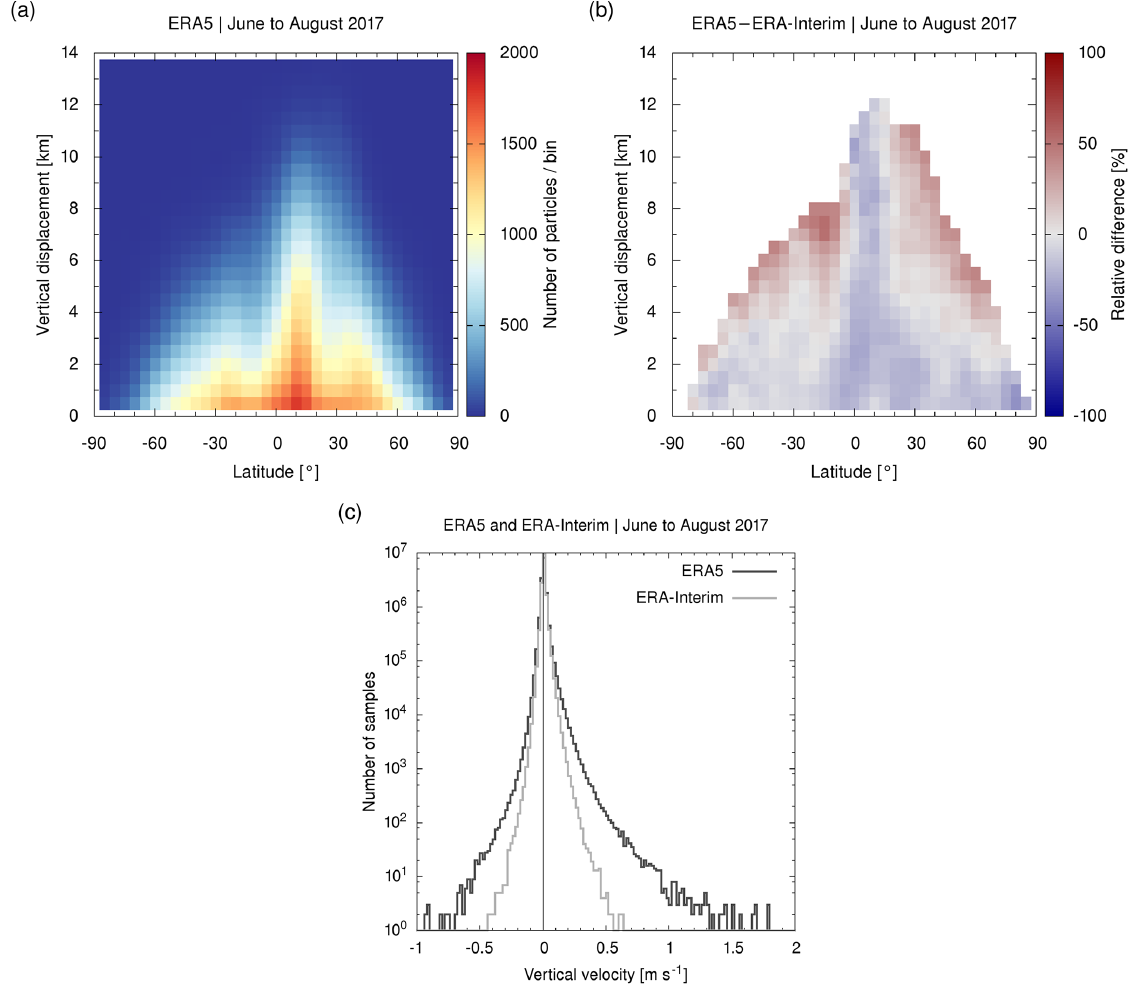
Figure 9. Comparison of total vertical displacements (a, b) and vertical velocities (c) of particles launched at an altitude of 2–8km for six sets of ERA5 and ERA-Interim 10-day forward trajectories from June to August 2017. Only trajectories with net updraft (positive vertical displacement) after 10 days of simulation time are considered. The bin size is 5 ◦ in latitude and 0.5km in altitude. Relative differences between ERA5 and ERA-Interim are only shown if at least 20 samples per bin are present. Vertical velocities are sampled every 6h along the